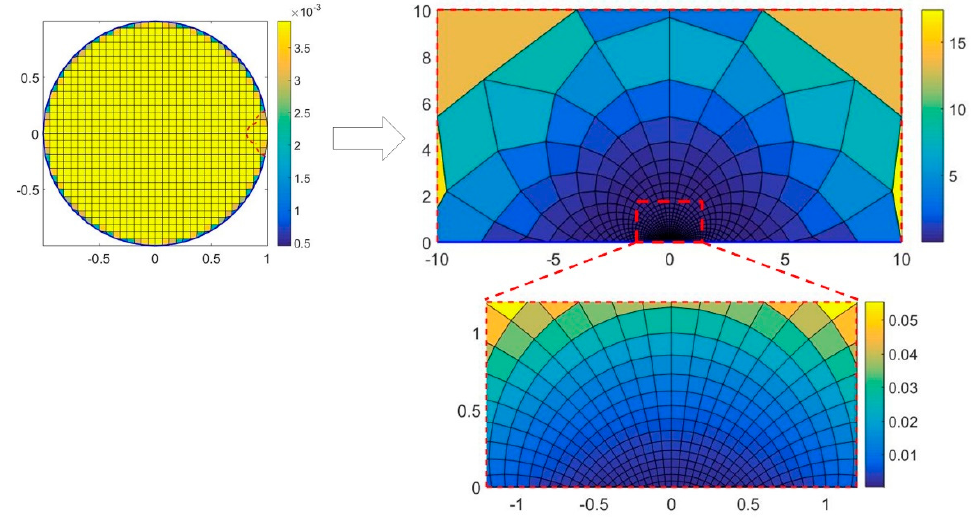
Figure 4. Inverse problem mesh based on conformal transformation.